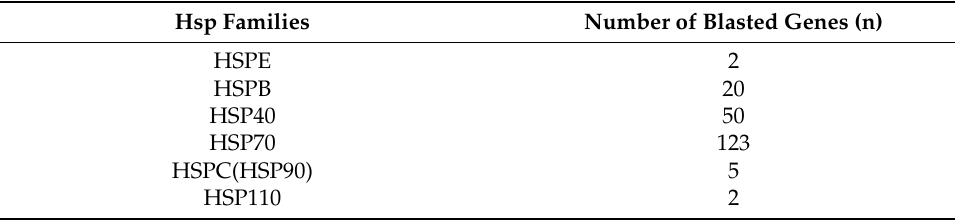
Table 1. Number of heat shock protein (Hsp) families for the heat shock response